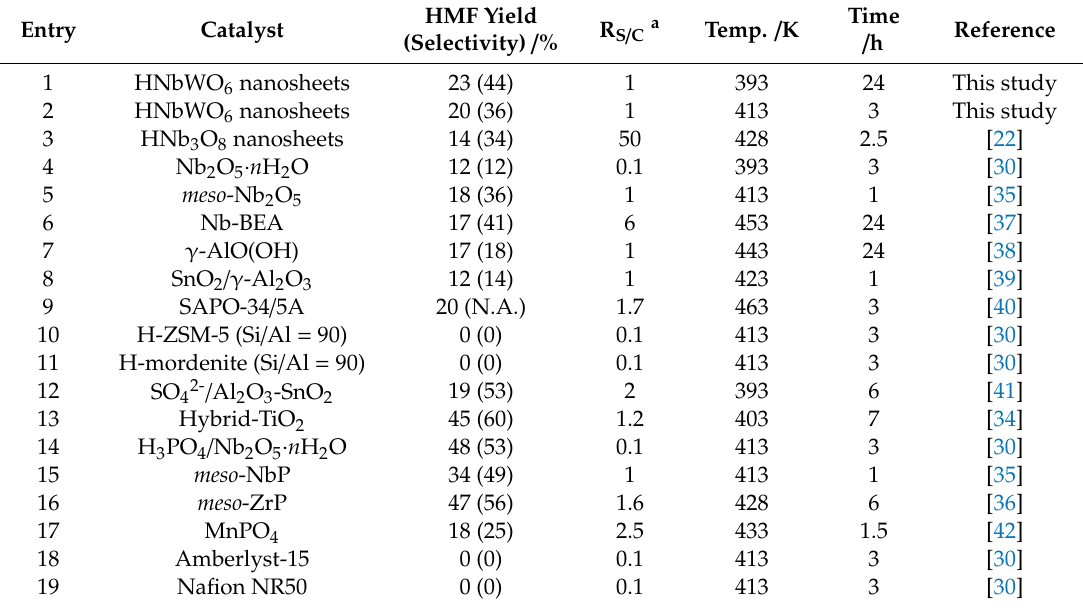
Table 3. Comparison of catalytic activity of solid acids for HMF production from glucose in